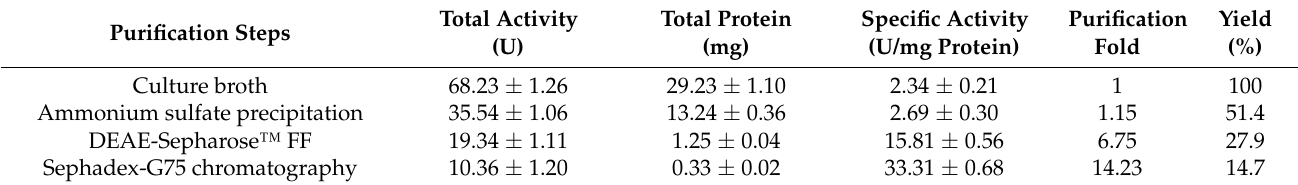
Table 1. Purification results of the protease from S. xylosus